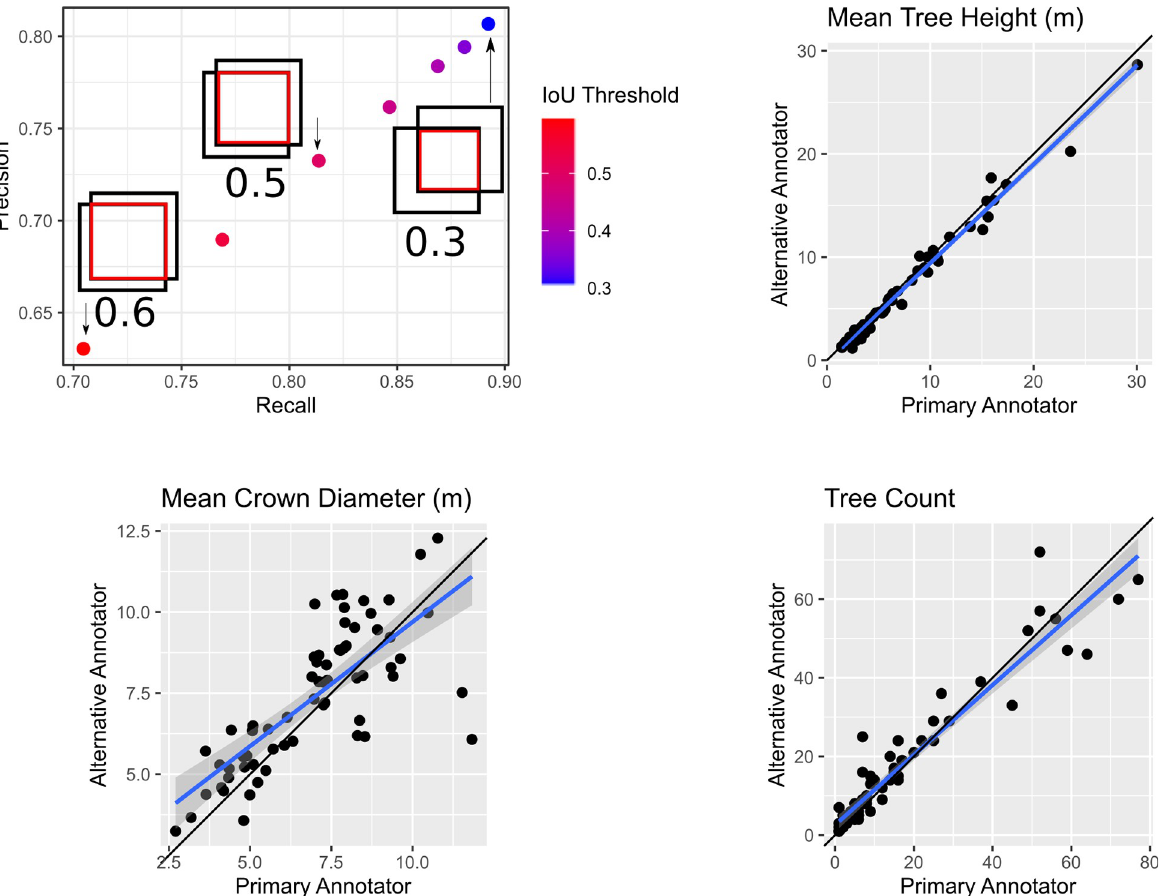
Fig 7. Intersection-over-union scores (top left), as well as plot-level inferences, between the primary annotator and a 2nd annotator. For the IoU scores, we plotted precision and recall for 7 different intersection-over-union thresholds. As the overlap threshold decreases, the two annotators tend to agree on ground truth tree crowns. Analysis is based on 71 evaluation images (n = 1172 trees) that were separately annotated by two different annotators.